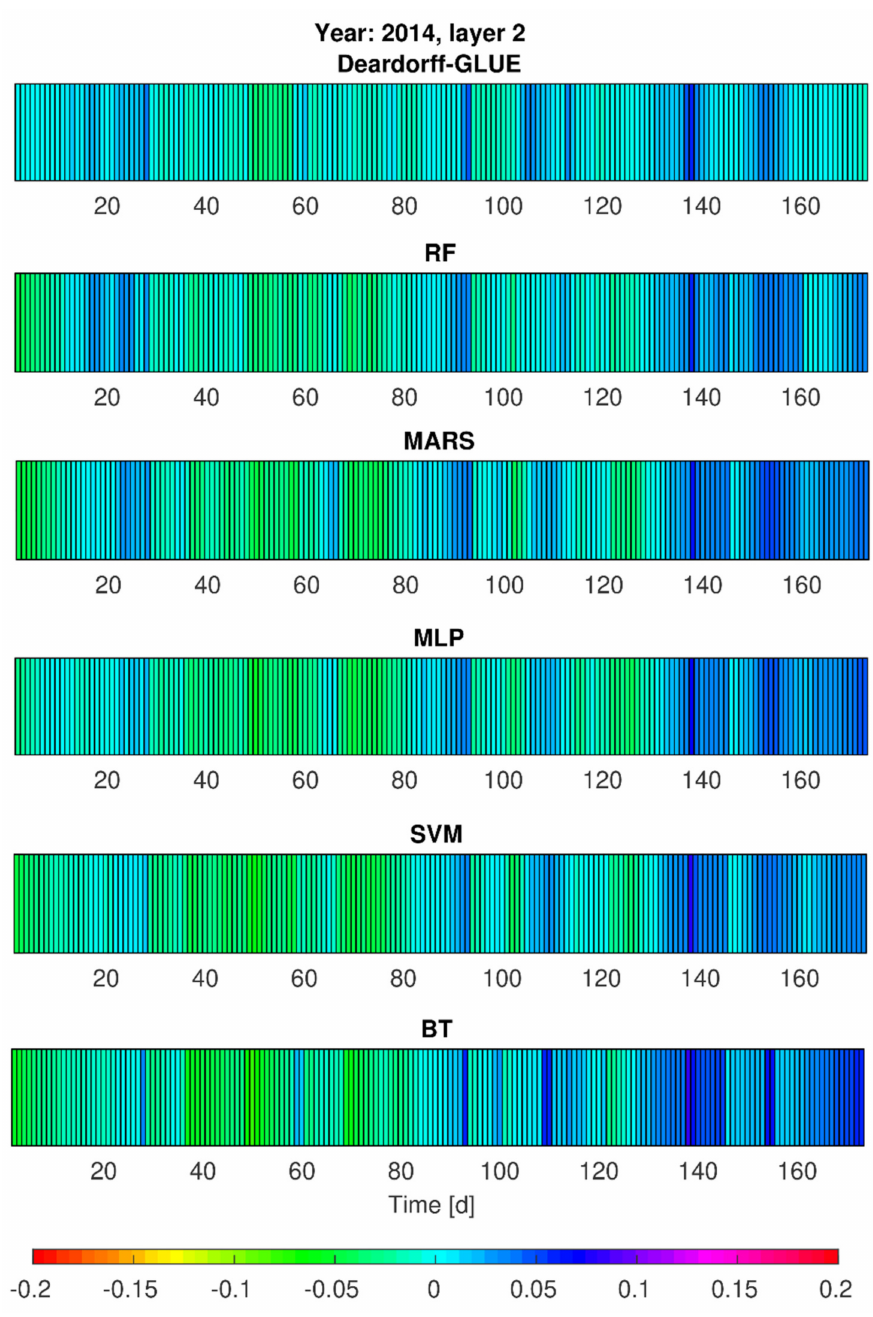
Figure 10. Error variability of the soil moisture content w 2 (second layer) for 2014 by Deardorff model and statistical methods (BT, RF, SVM, MLP,